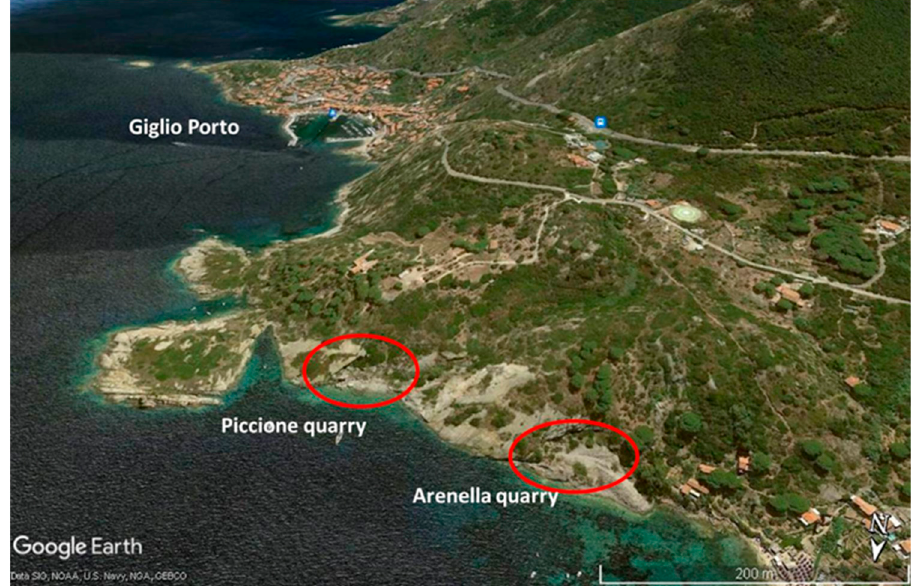
Figure 1. Location of the ancient quarries of Piccione and Arenella in the east side of the island (modified from Google Earth).